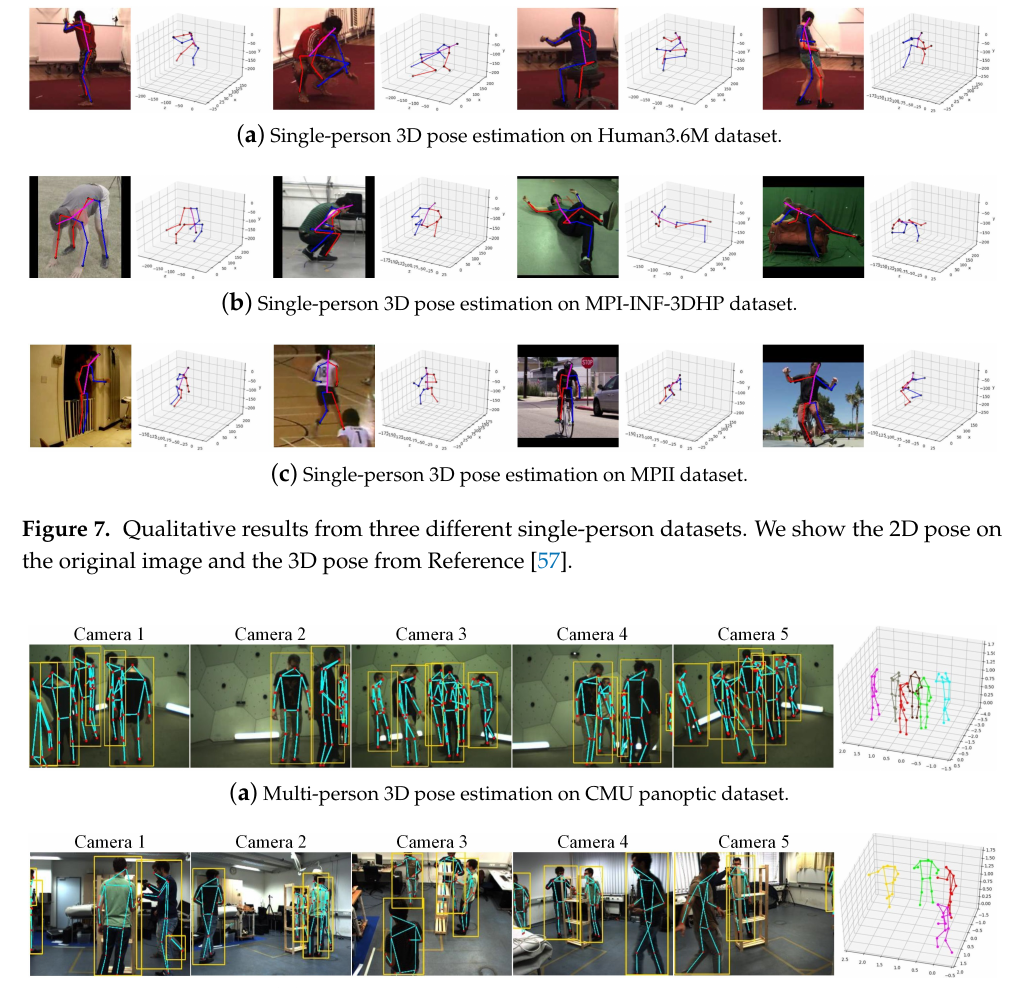
( b ) Multi-person 3D pose estimation on Shelf dataset. Figure 8. Qualitative results from two different multi-person datasets. The five leftmost columns, respectively, show the 2D bounding boxes and pose obtained from five different cameras. The rightmost column shows the estimated 3D poses from Reference